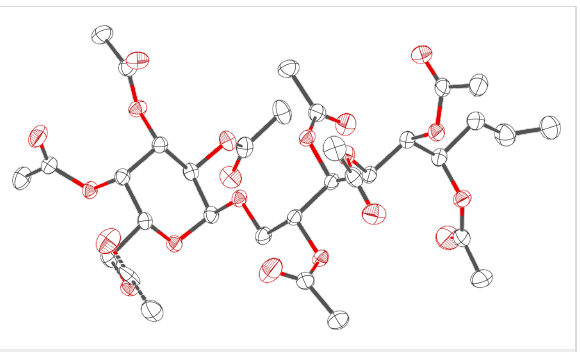
Figure 1: X-ray analysis of the main C-allylation product 2- syn [CCDC 1922520].